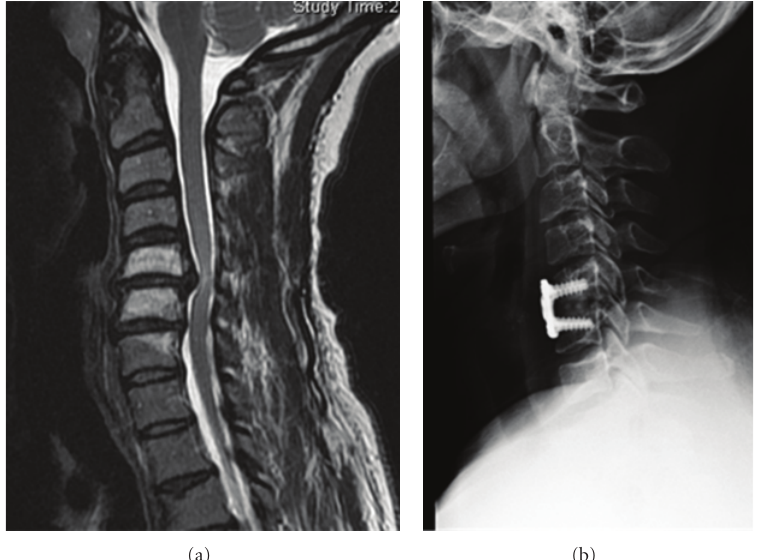
Figure 1: (a) Sagittal MRI demonstrating C5-6 extruded disc herniation. (b) Lateral radiograph of same patient after undergoing anterior cervical discectomy and fusion.